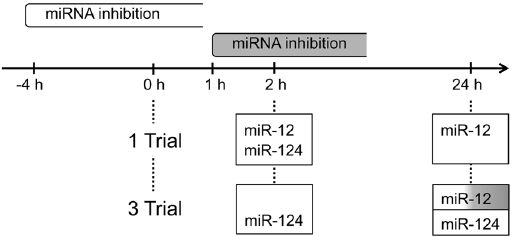
Figure 6. Scheme illustrating the contribution of different miRNAs to early associative memory phases in honeybees. The scheme visualizes the different time windows of miRNA inhibition. The inhibitors were either injected 4 h before (white) or 1 h after (grey) conditioning. The miRNAs that contribute to distinct early memory phases induced by either 1-trial or 3-trial conditioning are indicated in the boxes. White boxes indicate the requirement of miRNA action in the time window 4 h before to at least 1 h after conditioning. Grey shading indicates the requirement of miRNA action in a time window starting from 1 h after